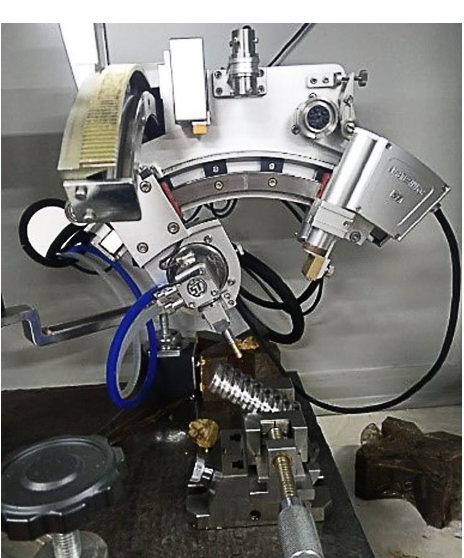
Figure 9. X-ray stress measurement device.